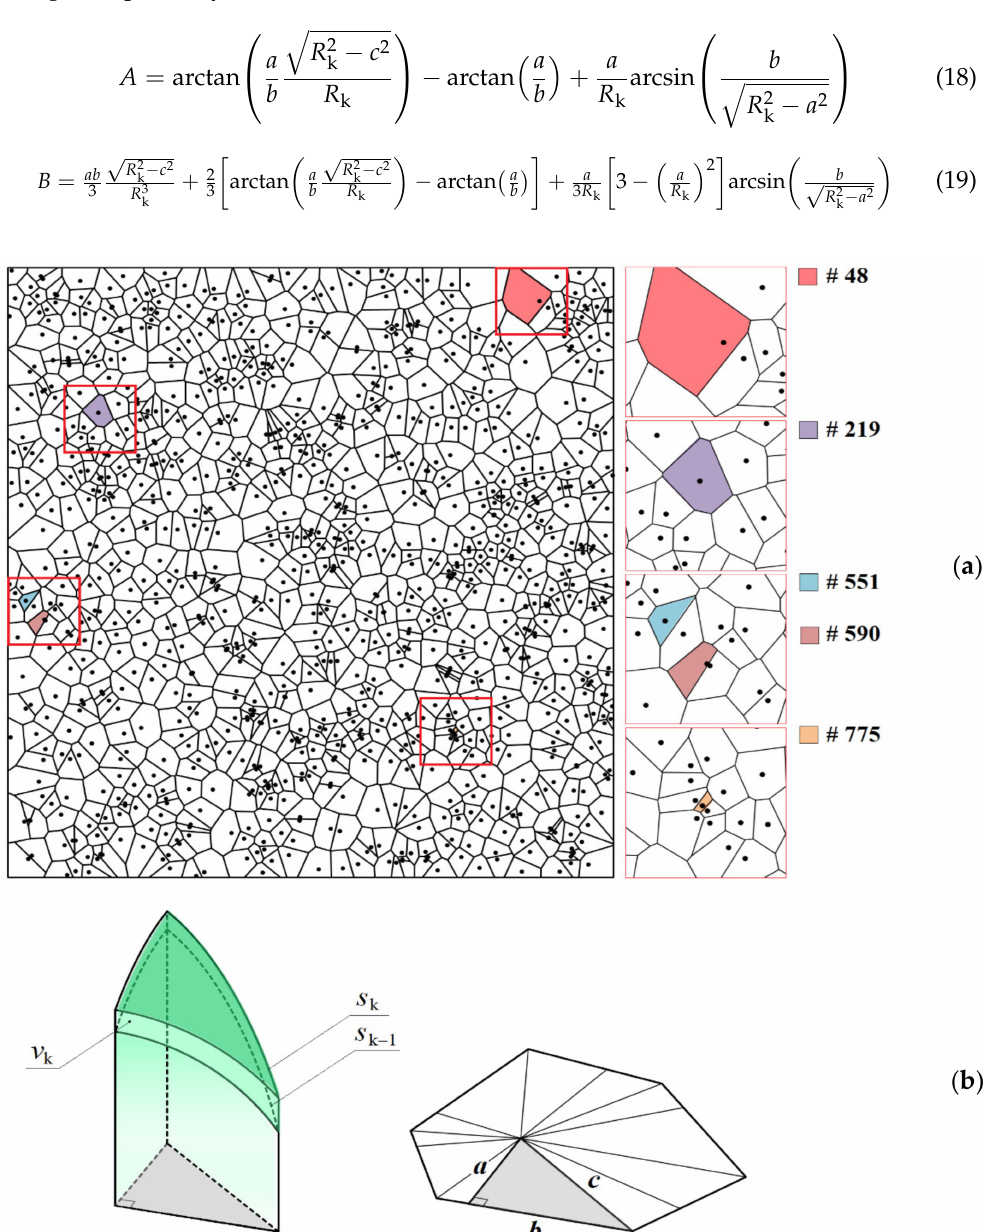
Figure 2. ( a ) Voronoi tessellation for 1000 nuclei and magnified images of selected domains. Areas of colored cells in ascending order of cell numbers (#), S v (cm 2 ): 6.13 × 10 − 6 , 2.13 × 10 − 6 , 7.06 × 10 − 7 , 8.77 × 10 − 7 , 1.17 × 10 − 7 . Half-distance from nucleus to the nearest neighbor for the same cells, R v (cm): 3.34 × 10 − 4 , 6.19 × 10 − 4 , 2.95 × 10 − 4 , 4.89 × 10 − 5 , 9.23 × 10 − 5 . The results of the calculation using ( a ) and their discussion are given in Section 3.2. ( b ) Schematic illustration explaining how S k and V k are calculated at a random spatial distribution of nuclei. Symbols a , b and c are included in Equations